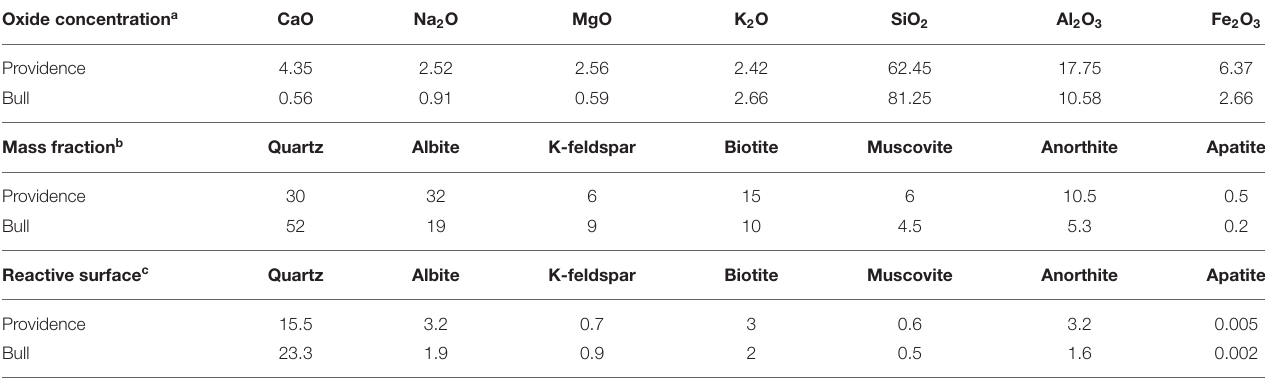
TABLE 1 | Geochemical and mineralogical data for the regolith of the KREW.